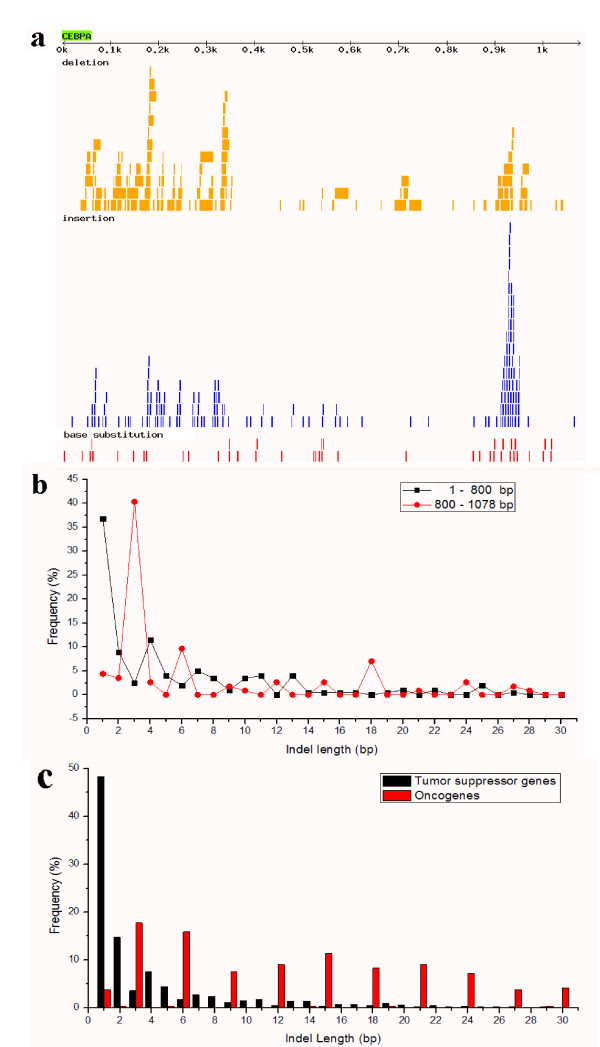
Abundance and size distribution of indels in the gene CEBPA and in oncogenes/tumor suppressor genes. (a) Mutational pattern in the CDS of CEBPA; (b) comparison of indel size distribution between 1 - 800 bp and 800 - 1078 bp region in CEBPA; (c) comparison of indel size distribution between oncogenes and tumor suppressor genes identified in Table 1. To make indels as less overlap as possible, only ≤30 bp indels are shown in (a). Only ≤30 bp indels are shown in (b) and (c).